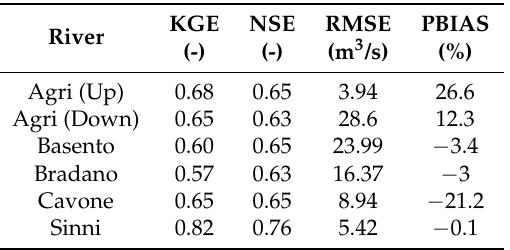
Table 9. Indices of goodness of fit obtained for the six investigated points.